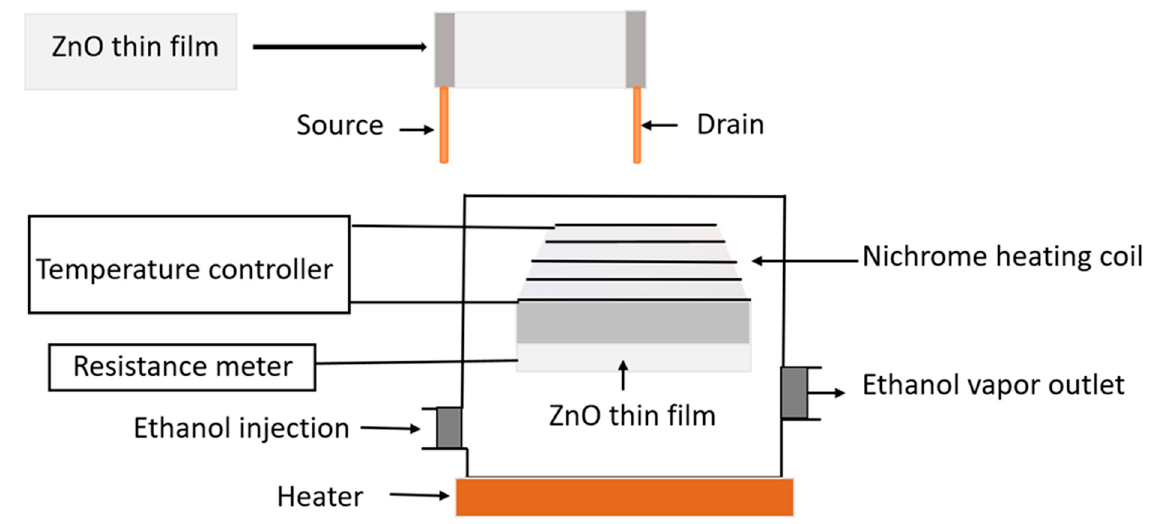
Figure 11. Schematic diagram of the gas sensor.